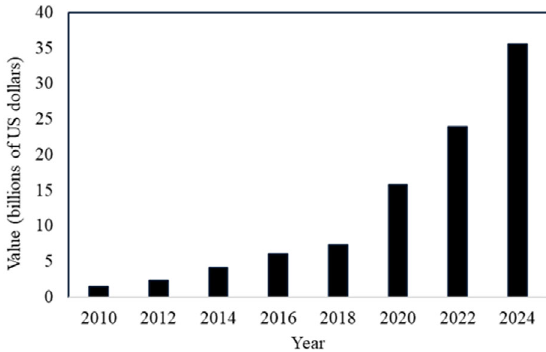
Fig. 30 Revenue growth of AM worldwide from 2010 to 2024.